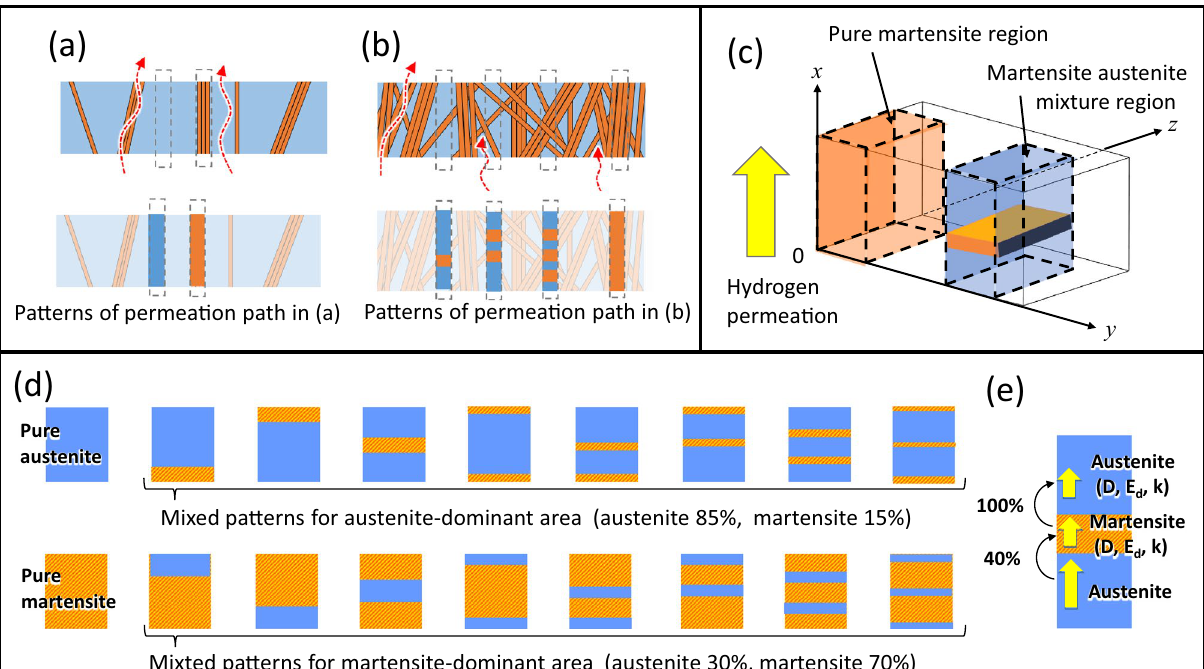
Figure 4. Schematic illustration of diffusion model of hydrogen permeation in a metal which has a dual structure. ( a ) Side view of an austenite-dominant region. There is a low percentage of martensite structures (orange) in the austenite structure (blue). Hydrogen permeates from bottom side to upper side (dashed red lines and arrows). ( b ) Side view of a martensite-dominant region. ( c – e ) Schematic images of mixed structures used for the simulation. ( d ) 18 block-patterns of austenite and martensite mixed structures are assumed for the simulation. Side views are shown as austenite (blue) and martensite (orange). For the austenite-dominant area, we chose values represented by region C (austenite 85% and martensite 15%). For the martensite-dominant area, we chose values represented by region G (austenite 30% and martensite 70%). Permeation path of hydrogen is from the bottom to top of each side view. ( e ) For the simulation we used diffusion coefficients ( D ), activation energies ( E d ), and solubilities ( k ) of austenite and martensite extracted from the literature, and used assumed values for the passage of hydrogen at the interface between